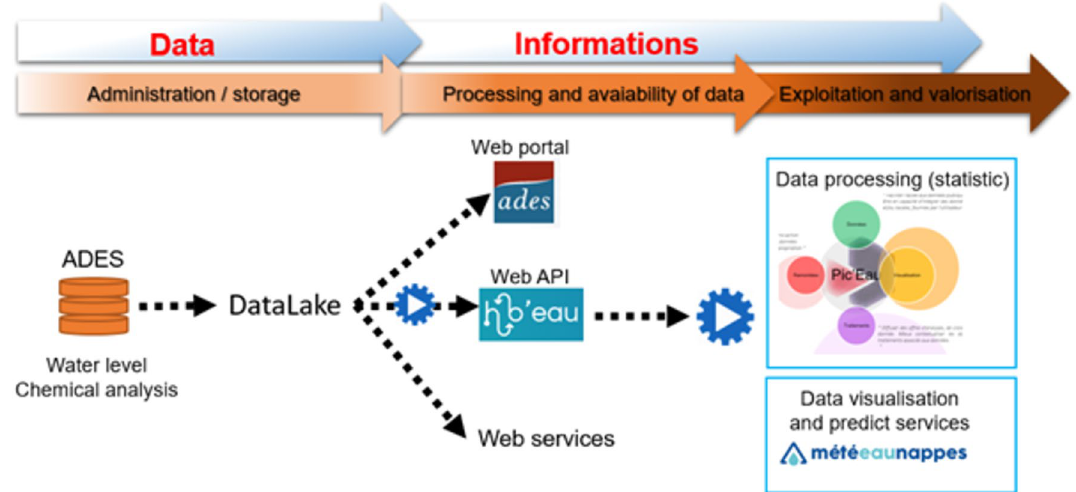
Fig. 4 Layout of the ADES data distribution